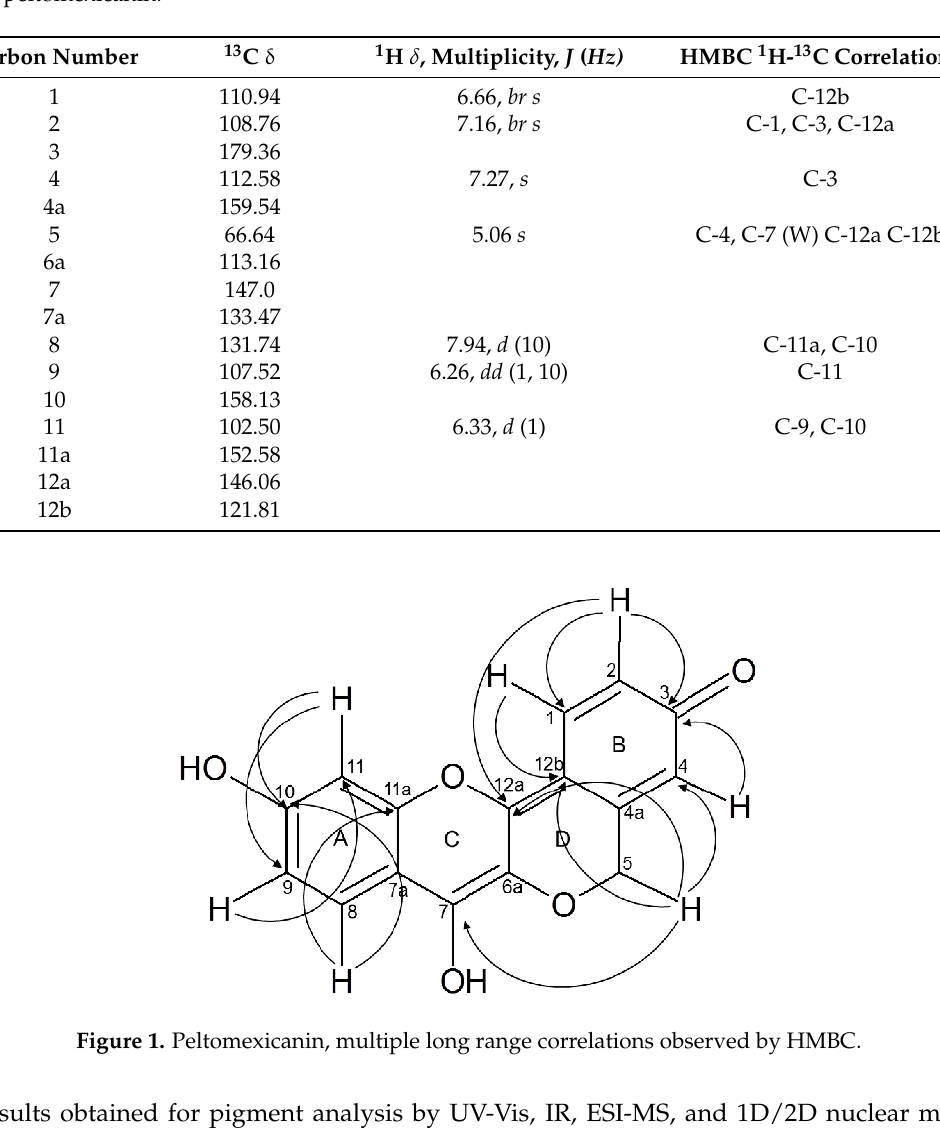
Table 1. 1 H- (500 MHz) and 13 C-NMR (125 MHz) (296 K in methanol- d 4 ) spectroscopic assignments for peltomexicanin. Carbon Number